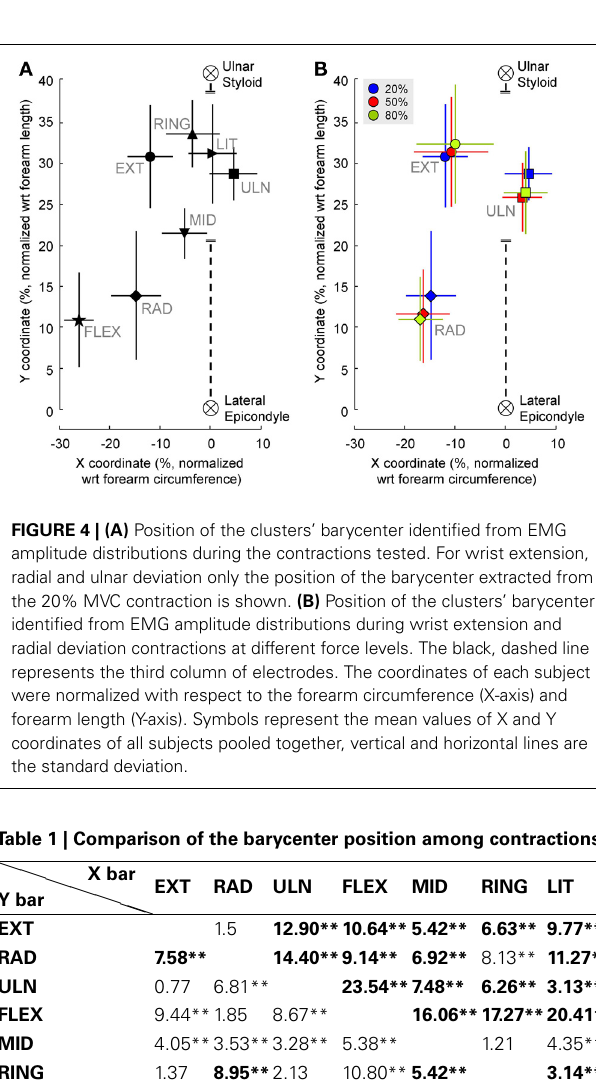
Results of post-hoc comparisons (Holm-Sidak t-values) are shown for medio- lateral (X, top-right half of the table indicated with X bar) and proximal-distal coordinates of the barycenter (Y, bottom-left half of the table indicated with Y bar).Boldhighlights whichcoordinatebestdiscriminateeachpairofcontractions. For example, EMG amplitude distributions associated to wrist radial (RAD) and ulnar (ULN) deviations can be distinguished with p < 0.01 ( ** ) in both directions, however, the Holm-Sidak t-value is higher in the X (14.4, top-right half of the table) than in the Y axis (6.81, bottom-left half of the table), indicating that the amplitude distributions can be better distinguished transversally to the